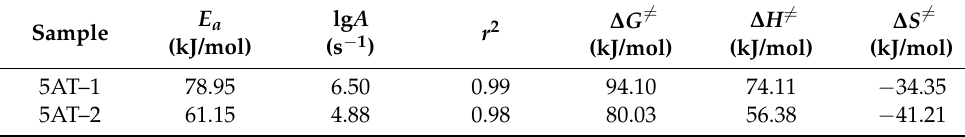
Table 4. Characteristic kinetic parameters calculated using ASTM